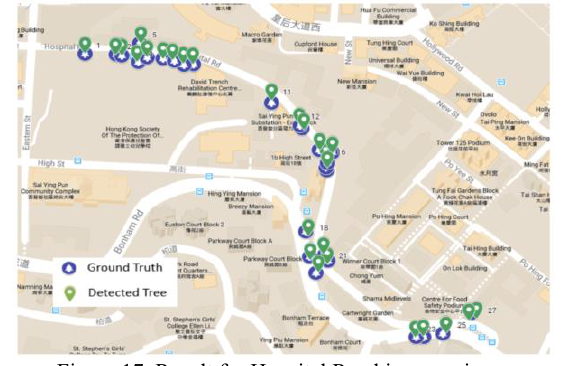
Figure 17. Result for Hospital Road in map view.